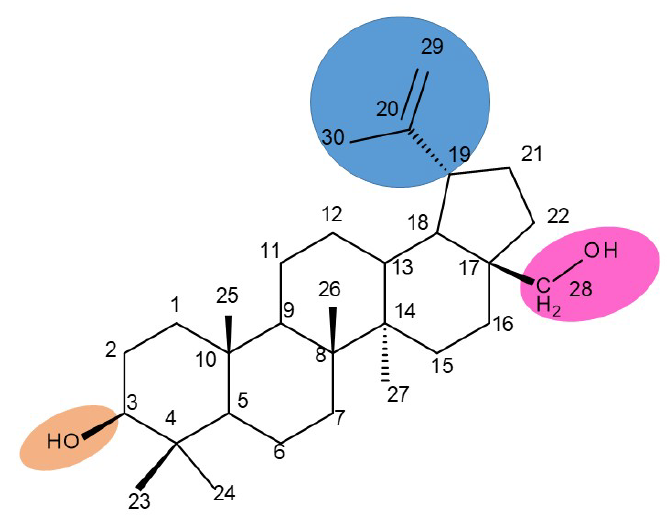
Figure 2. Frequent targets for the derivatization of betulin.